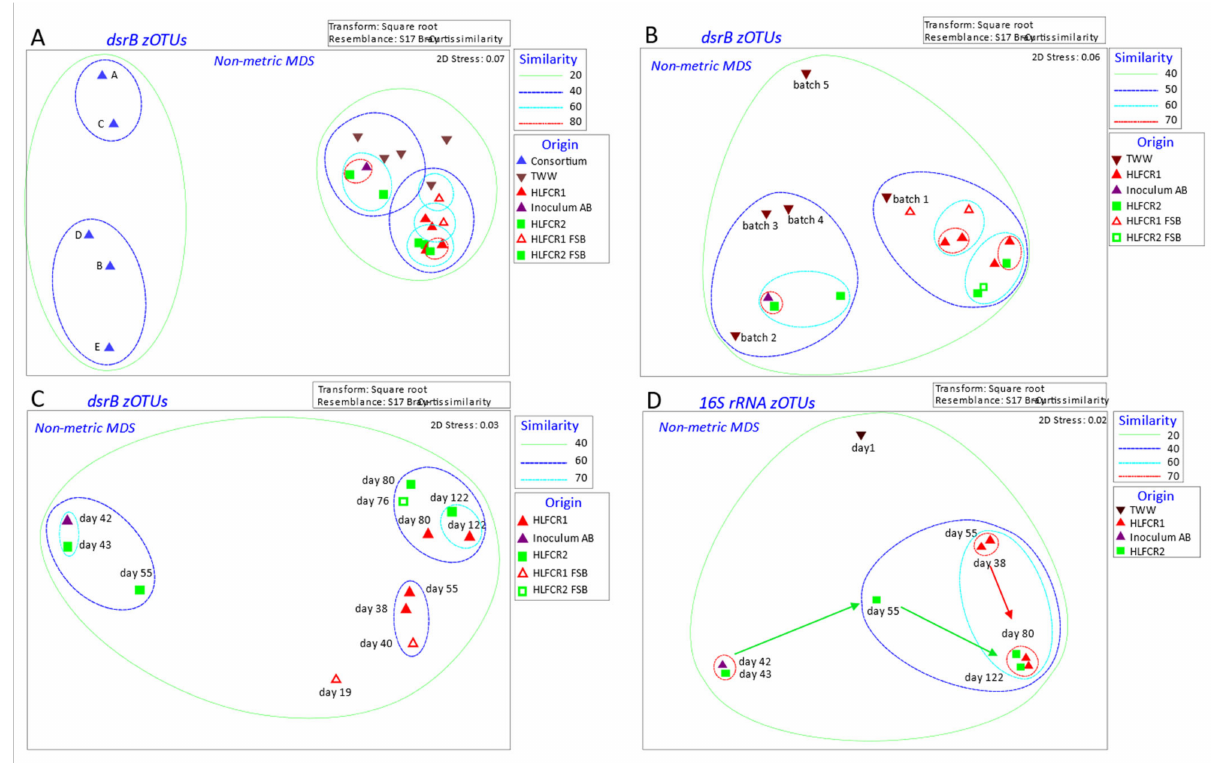
Figure 3. nMDS plots with data points representing Bray–Curtis similarities of all transformed: dsrB amplicon zOTU samples ( A ), dsrB amplicon zOTU samples with consortia removed ( B ), dsrB amplicon zOTU samples with consortia and tannery effluent removed ( C ), and all 16S rRNA amplicon zOTU samples ( D ). Samples of TWW batches 1–5 taken on day 12, 33, 47, 72, 96,